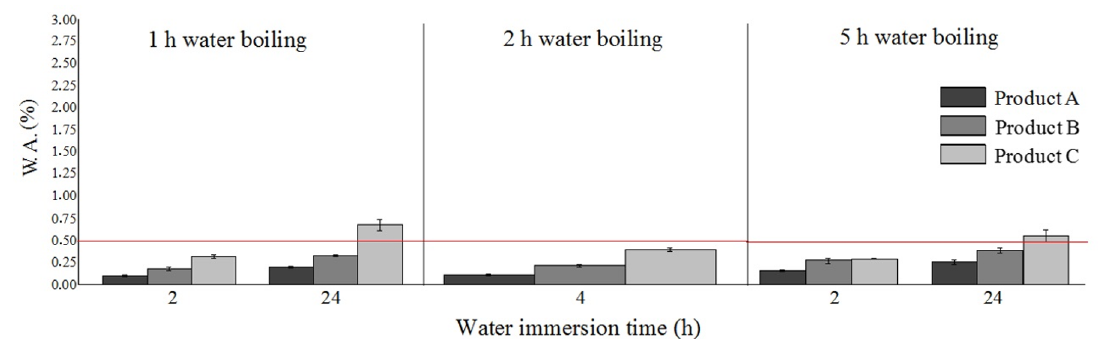
Figure 2. WA in function of the water immersion time obtained by the standard ISO 10545 for different water boiling